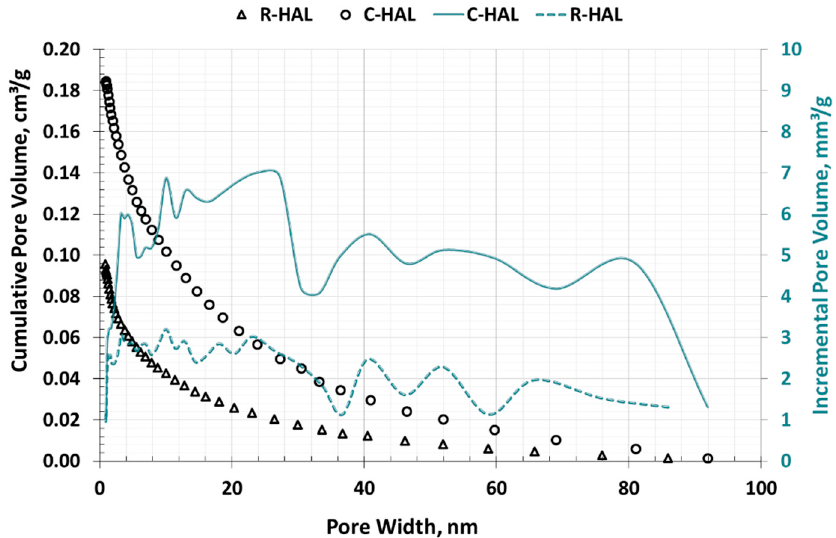
Figure 6. Distribution of pore volume as a function of their diameter in halloysites (LPNA method, BJH model) .